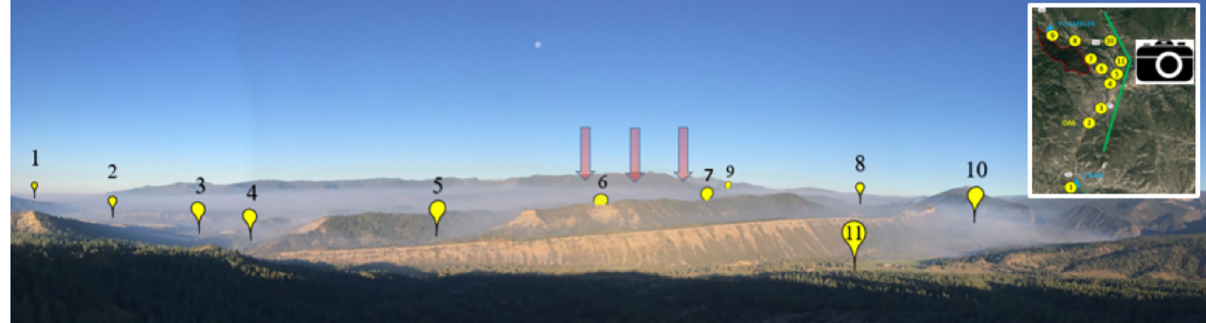
Figure 5. View from Chimney Rock, facing west on the morning of 18 September 2016 when smoke is visible in several valleys (Photo courtesy of Columbine Wildfire Management). OAS locations depicted by yellow markers. Visible smoke is observed around several OAS while other locations appear to be smoke free. Red arrows indicate location of prescribed fire